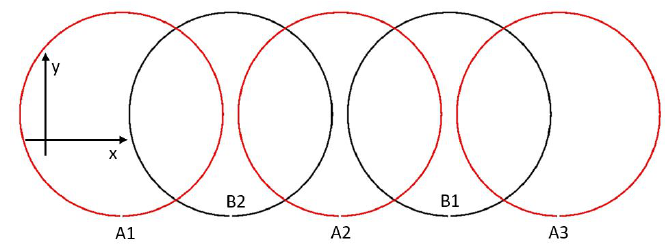
Figure 3. Case 1: geometry analyzed for Case 1. In red the transmitting coils and in black the receiving coils.